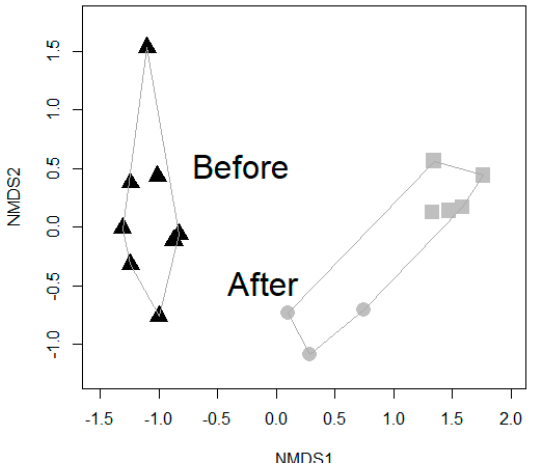
Figure 3. Non-metric multidimensional scaling (NMDS) at the OTU level showed that bacterial communities differed after the daycare yards were transformed with green materials. Triangle = mineral soil, Circle = sod, and Square = forest floor. OTU = operational taxonomic unit with a 97% identity, an operational definition used to classify groups of closely related individuals. OTU is often used as a synonym of bacterial species.